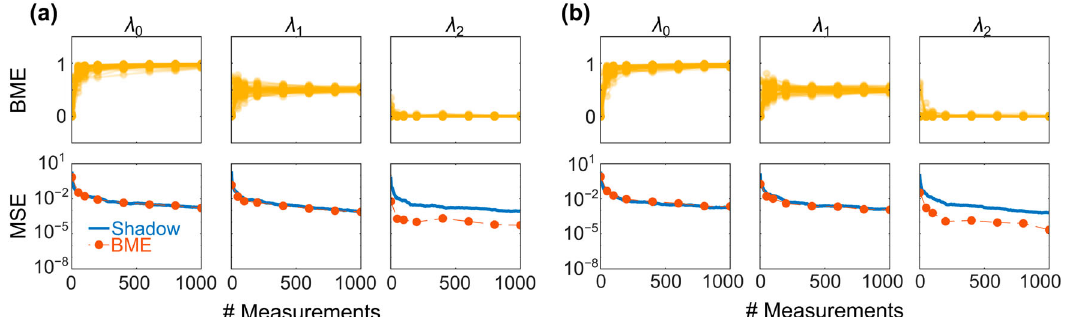
Fig. 4 Bayesian estimation using the pseudo-likelihood of Eq. (10) with N = 3. a Results for D = 32. b Results for D = 256. The MSE values for shadow from Fig. 1 are reproduced for comparison.